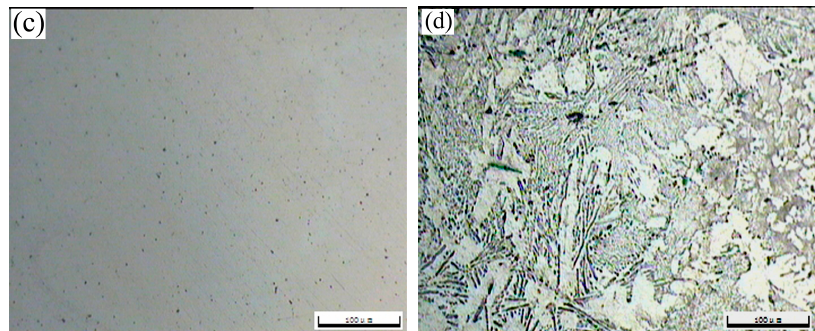
Figure 2. OM images of as-cast Mg-3Sn ( a ) and Mg-3Sn-1Ca ( b ), solution treated Mg-3Sn ( c ), and Mg-3Sn-1Ca ( d ) alloys for 28 h at 733 K.